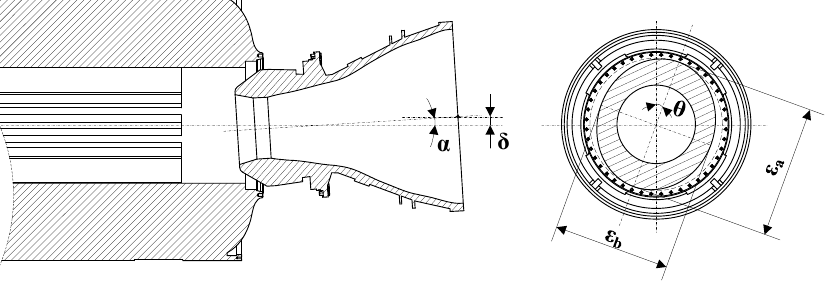
Figure 3. Assembly condition